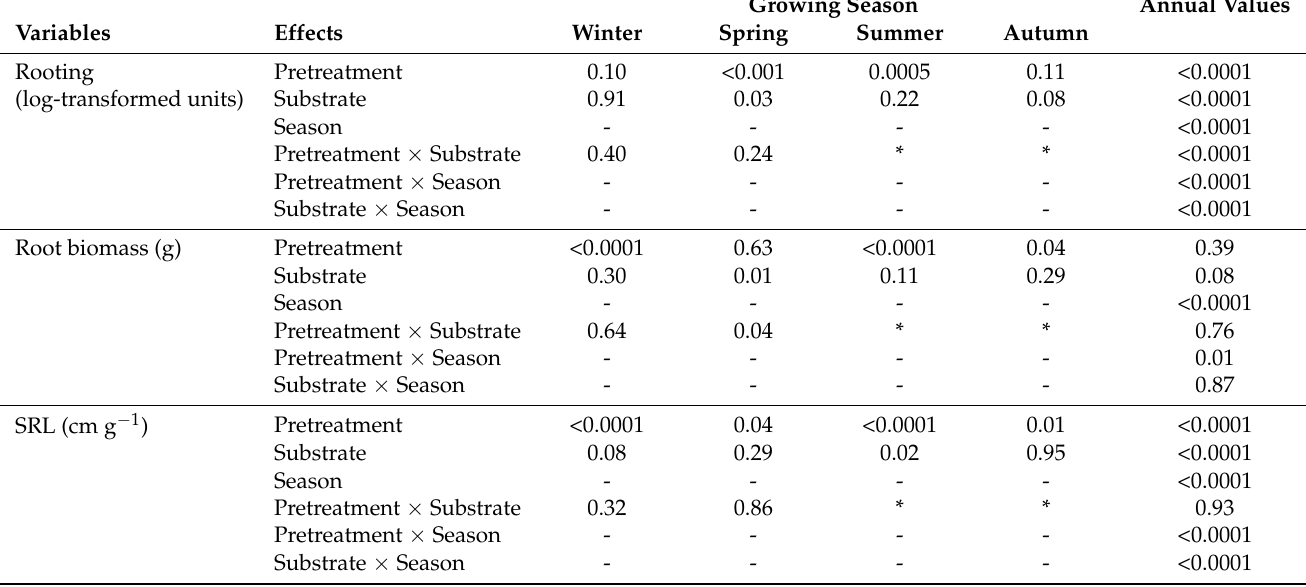
Table 1. Results of multifactor ANOVA of effect of main factors on rooting performance of cuttings across four seasons. Shown are p -values for three principal effects (pretreatment with IBA, substrate, and season, and their two-way interactions) and effects within each season (pretreatment, substrate, and their interaction). Effects were considered significant when p < 0.05. A total of 540 stem cuttings were planted each